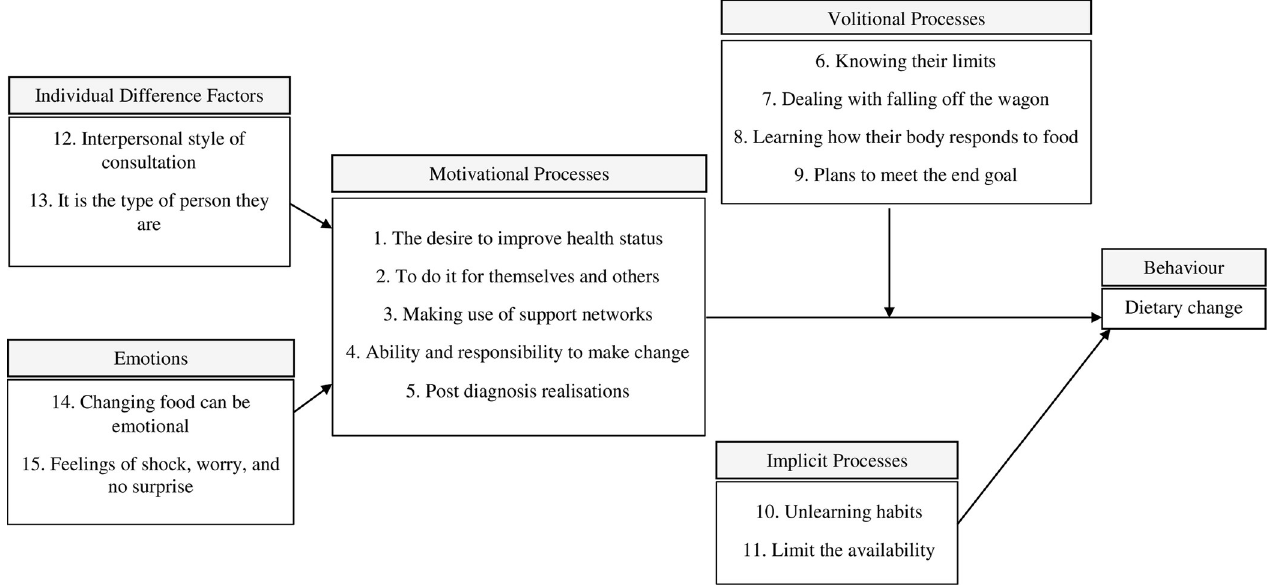
Fig 1. Visual representation of the 15 themes identified in a qualitative study exploring the decision-making processes of dietary behaviour change after a diagnosis of type 2 diabetes guided by the motivational, volitional and implicit processes of the integrated behaviour change model [17].